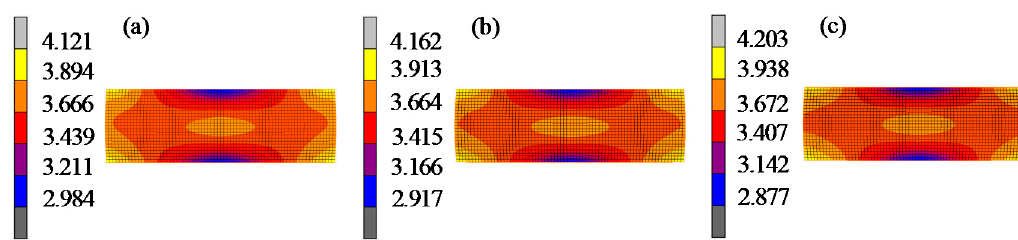
Figure 12. Residual stress contrast of the glass cylinder at 544 °C: ( a ) test 1; ( b ) test 2; ( c ) test 3.